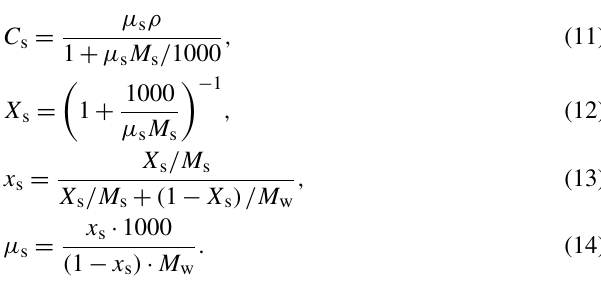
composition and units of concentration. For